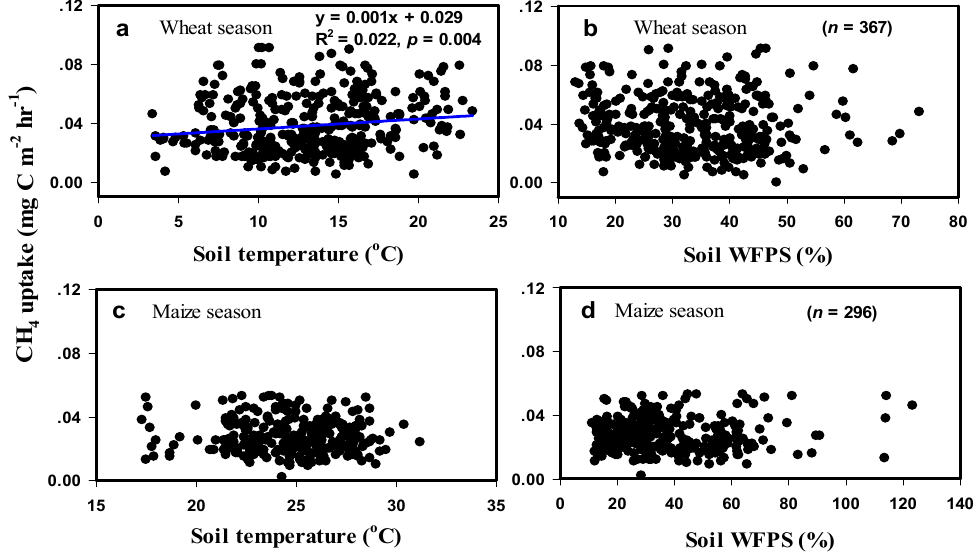
Figure 6. Relationships between CH 4 uptake, soil temperature, and soil water ‐ filled pore space (WFPS) in the wheat season ( a and b ) and in maize season ( c and d ) for the wheat and the maize seasons across the four treatments over the two ‐ year period from 2016 – 2018.